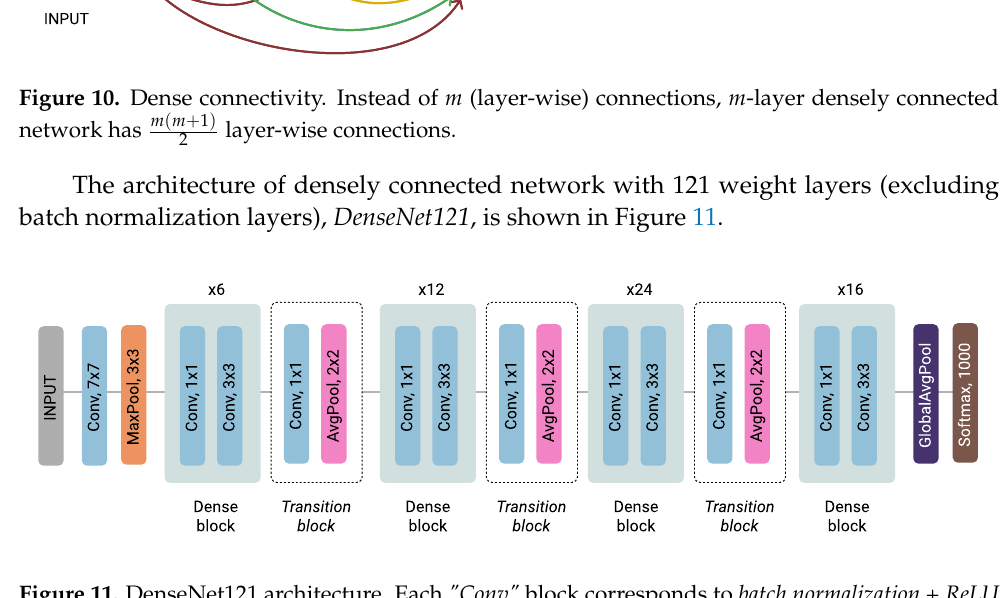
Figure 11. DenseNet121 architecture. Each "Conv" block corresponds to batch normalization + ReLU + convolution .